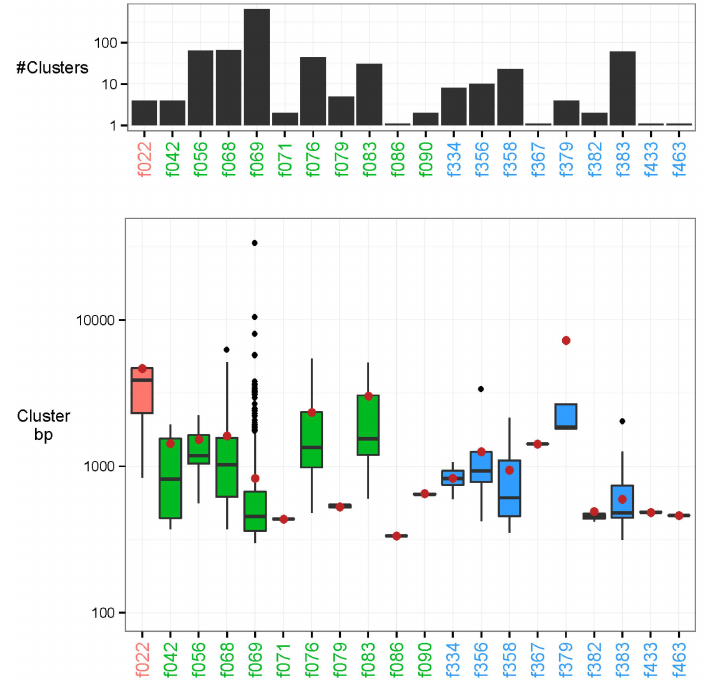
Figure 4. Unmapped clusters. The clusters are placed by their strongest associated feature. Feature types are marked in colour as follows: biological (red), methodological (green), and technical (blue). Top: Number of clusters associated to each feature on a log-10 scaled axis. There are 648 associated clusters of feature DNase/RNase: Promega DNase stop solution (f069), and 1 associated cluster to feature Polymerases: Phusion HF, NEB (f086). Bottom: Base-pair length (bp) of all cluster representatives (longest contig of each cluster) on a log-10 scaled axis. The N50 of all unmapped cluster representatives are marked by a brown dot. The longest cluster representative is 33.6 kb with N50 = 617